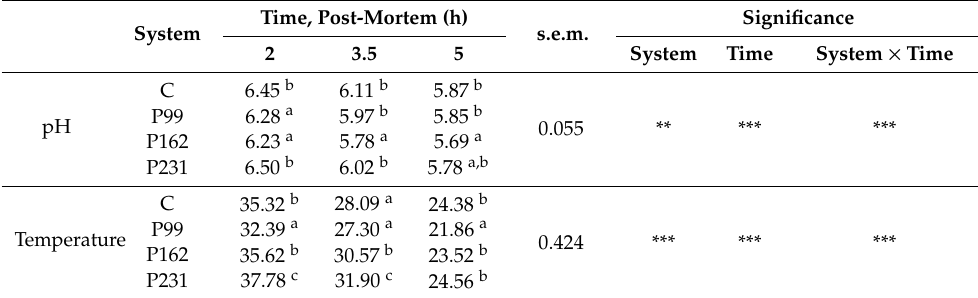
Table 2. Post-mortem pH and temperature of longissimus thoracis muscle from bulls raised on either a concentrate-based system (C) or pasture-based systems incorporating 99 days (P99), 162 days (P162) or 231 days (P231) grazing prior to indoor finishing on a concentrate-based